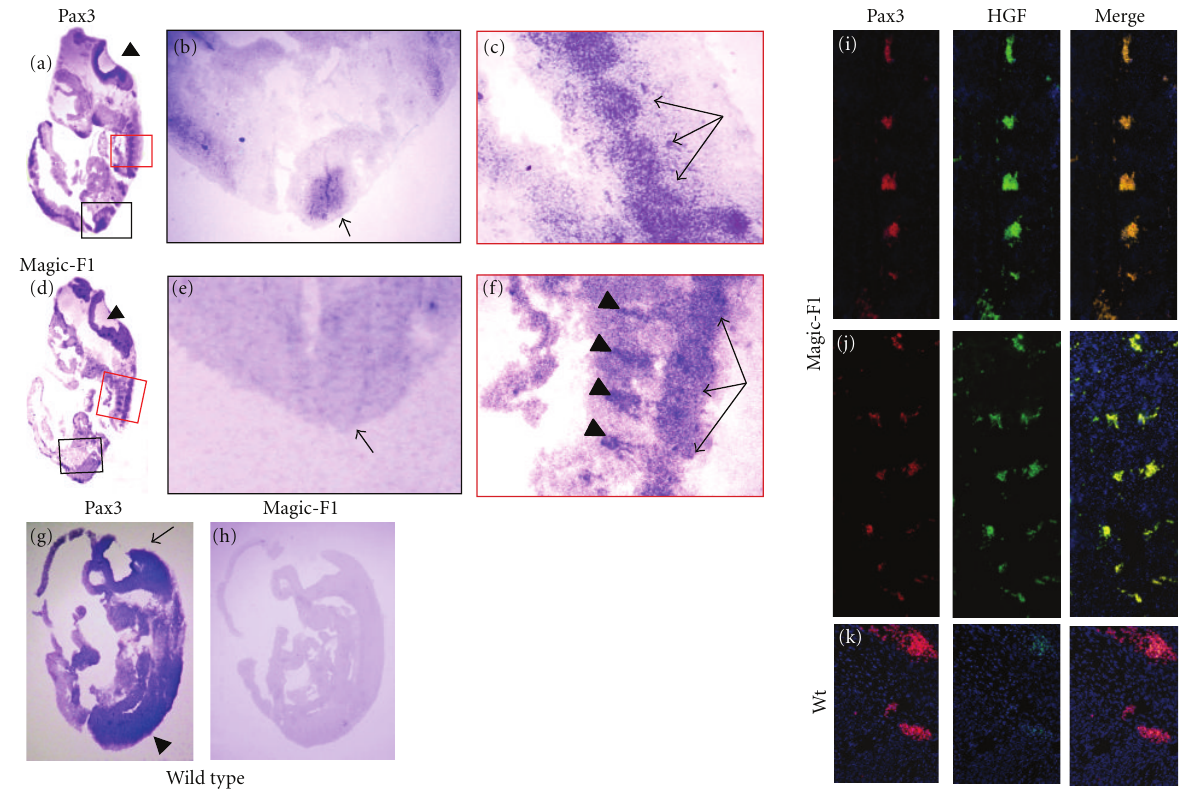
Figure 3: Transcription expression profile of Pax3 (a–c) and Magic-F1 (d–f) on 11.5 dpc mouse embryos of hemizygous Magic-F1 (a–f) and wt (g, h) mice by in situ hybridization. In the sagittal section of transgenic embryo, Pax3 riboprobes reveal a strong signal at the level of hindbrain (arrowhead in a), neuroepithelium of neural tube (arrow in b), and dorsal somites (c); sagittal section of 11.5 dpc embryo hybridized by Magic-F1 riboprobes (d) shows a similar pattern of Pax3 although no expression was detected at the level of neuroepithelium of neural tube (arrow in e); specific transcripts are observed in the cervical dorsal (posterior) root ganglion (arrows in c and f) and somites (arrowheads in f). In 11.5 dpc wt embryo hybridized with Pax3 riboprobes (g), specific transcripts are detected mostly in the cerebellar primordium (cerebellar rudiment derived from dorsal part of the alar lamina of the Metencephalon) (arrow) and somites in lumbar region (arrowhead in g), whereas no signal for Magic-F1 has been detected (h). Immunofluorescence analysis confirmed the presence of recombinant protein at the level of thoracic (i) and lumbar (j) somites in the transgenic embryos, whereas the signal was faint in the wt embryos (k), probably referred only to the HGF expression at this